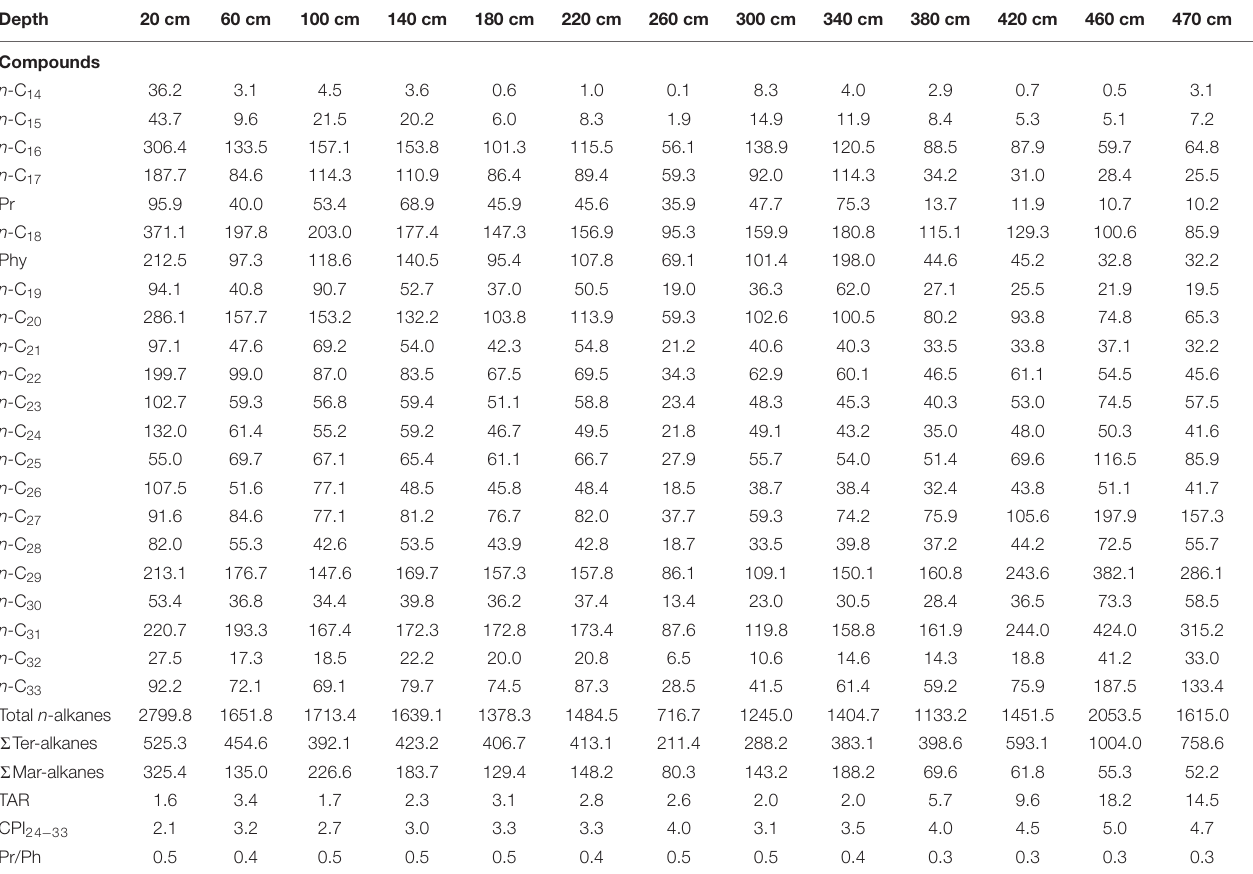
TABLE 2 | Concentration (ng/g sed.dry weight) of hydrocarbon in A station of the Southwest Sub-basin. Depth 20